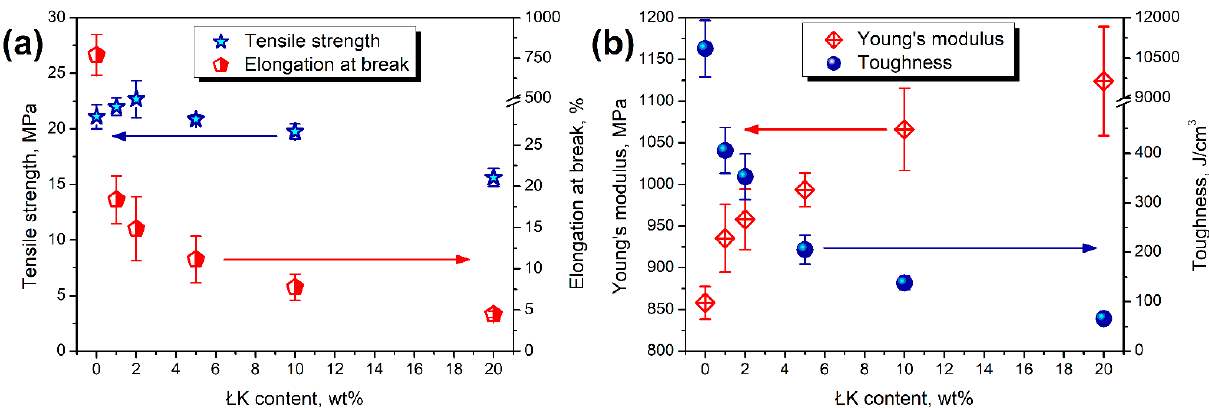
Figure 4. The impact of coffee silverskin content on the ( a ) tensile strength and elongation at break, ( b ) Young’s modulus and toughness of prepared